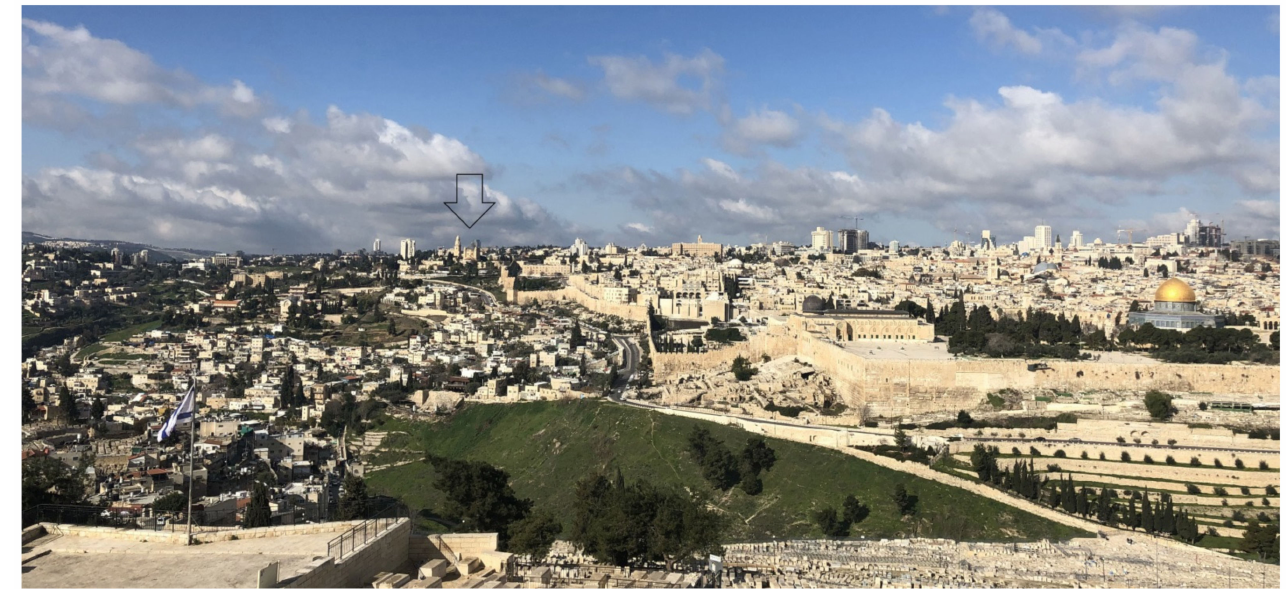
Figure 8. Exemplary distant, east observation direction (K3) of the site.